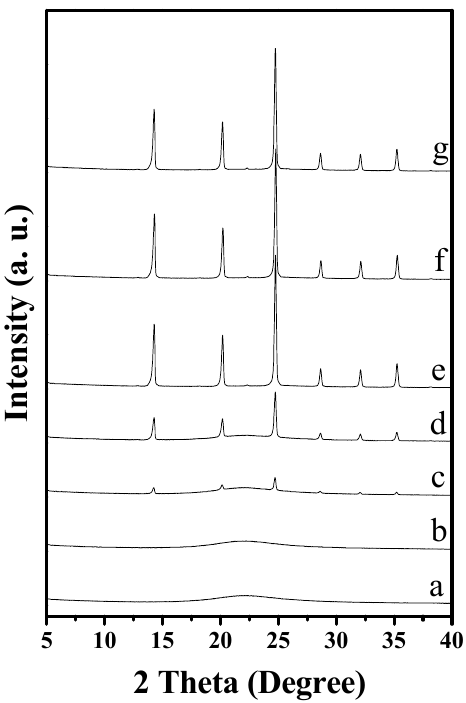
Figure 7. XRD patterns of S–Si–SOD zeolites crystallized at 200 ◦ C for ( a ) 0, ( b ) 8, ( c ) 12, ( d ) 14, ( e ) 16, ( f ) 20, and ( g ) 24 h,